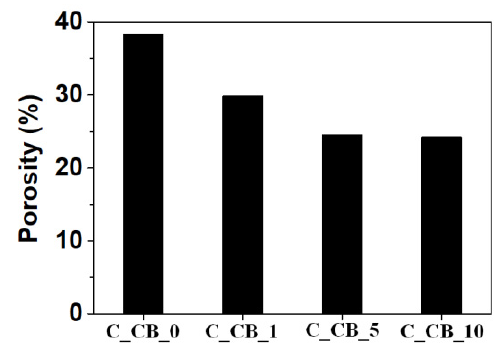
Figure 7. The porosity of carbon blocks according to the added CB amount.